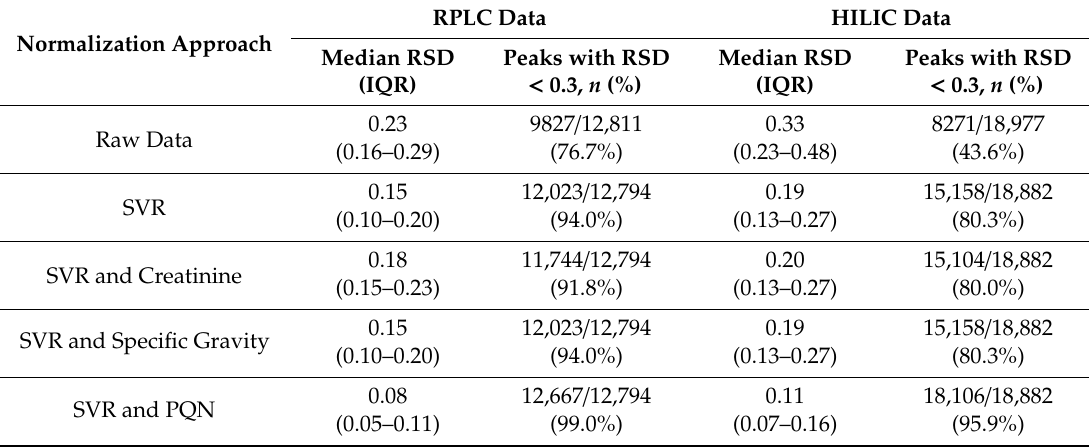
Table 1. Comparison of relative standard deviation of peak area for quality control samples across normalization approaches.